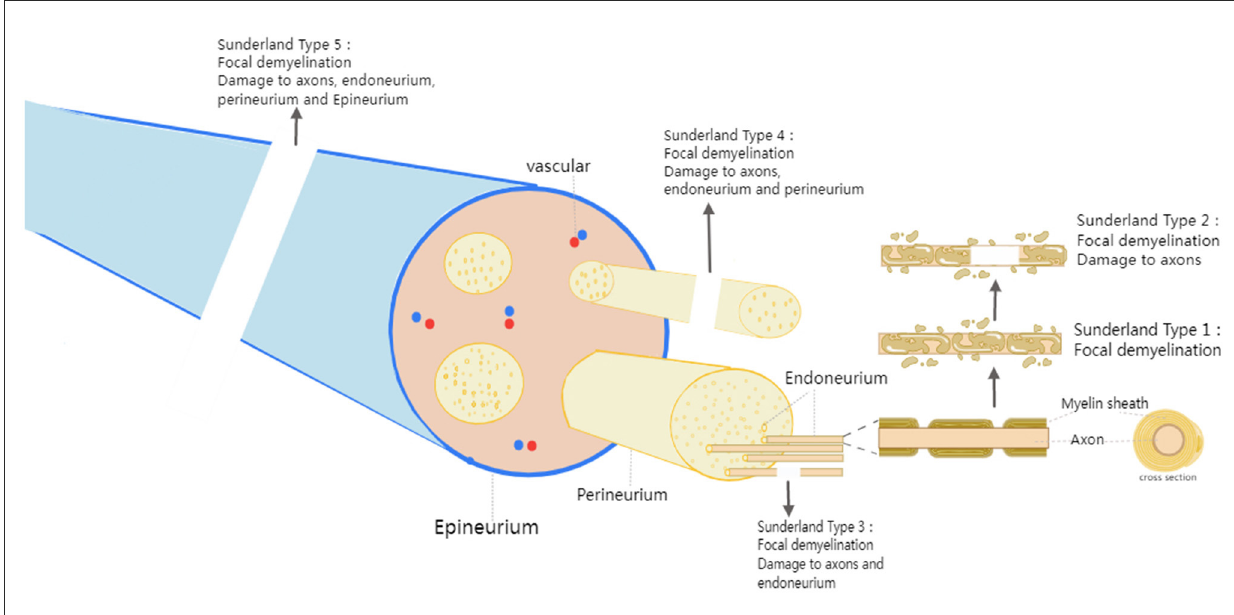
FIGURE1 Peripheral nerve anatomy and classification of peripheral nerve